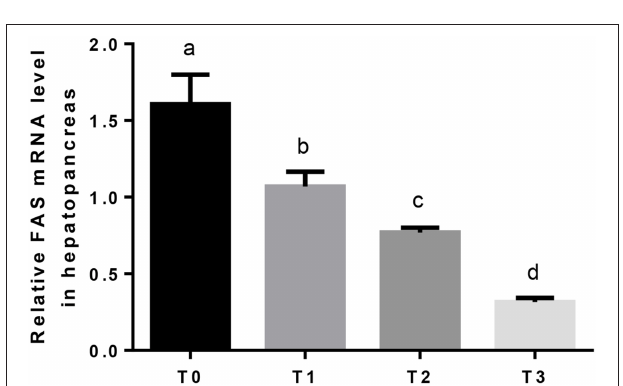
FIGURE 5 | The relative expression of FAS mRNA in the hepatopancreas. The letters indicate the results of multiple range test, the different letters indicated significant differences ( P <